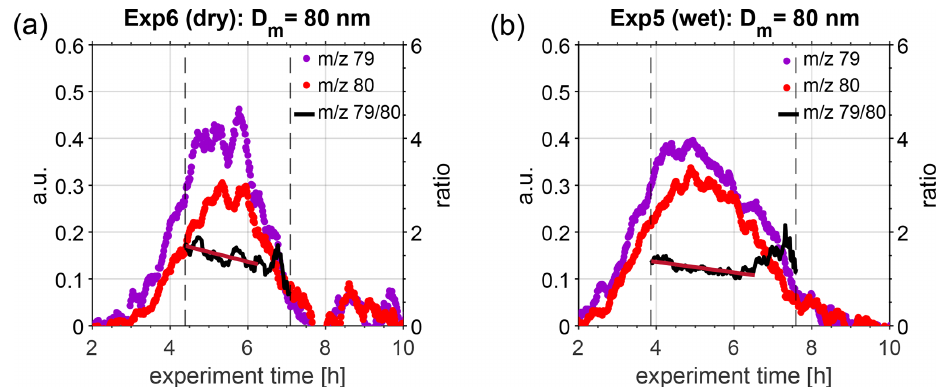
Figure 3. Temporal evolution of m/z 79 (violet dots) and 80 (red dots), representative for MSA and ammonium sulfate, respectively, as measured in the HR-ToF-AMS during (a) Exp. 6 (dry conditions, T = 293K) and (b) Exp. 5 (wet conditions, T = 293K). The black solid lines denote the ratio of m/z 79 to 80, as calculated during the main particle growth mode in the chamber (represented by vertical dashed lines). A linear fit was calculated for the ratio during the time period where both ions had a signal higher than 0.2 (dark red line), indicating a linear decrease over this